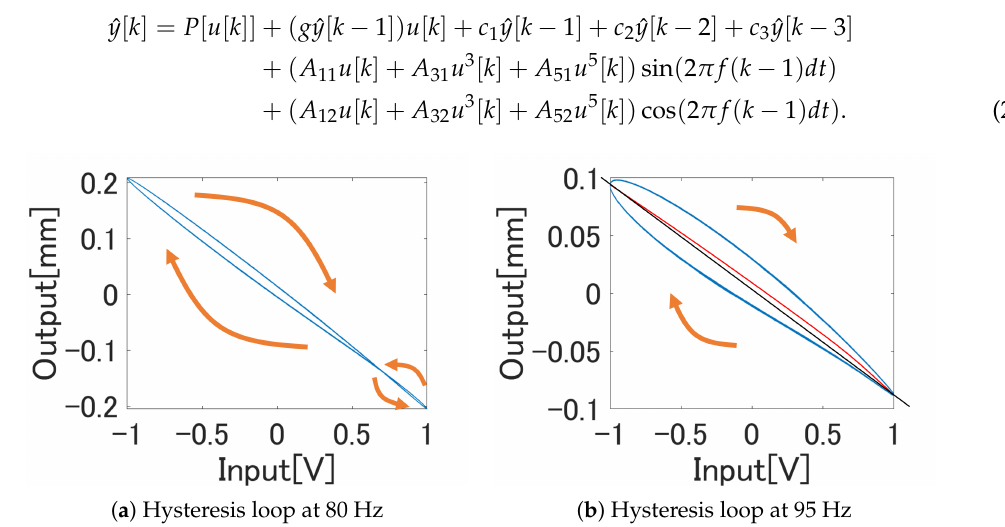
Figure 9. Peculiar hysteresis loops observed at frequencies higher than the resonance